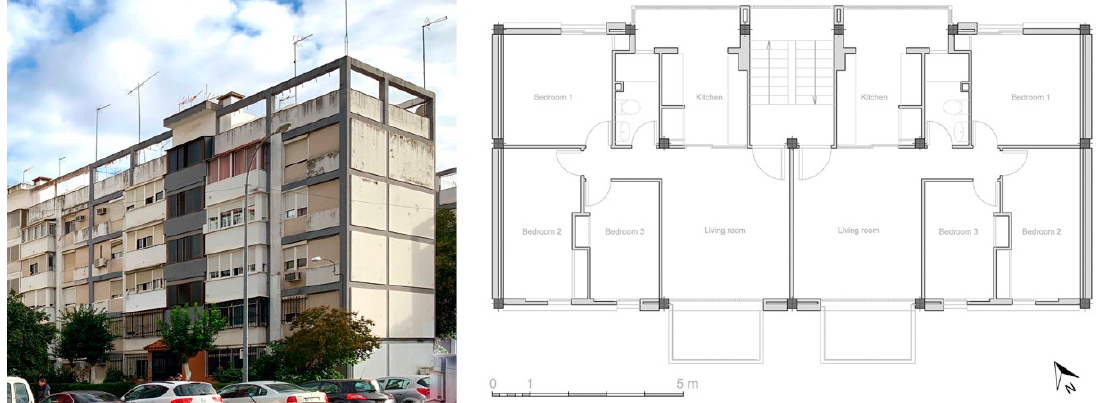
Figure 2. Exterior view and floor plan of a reference building belonging to the case study category. Table 2. Characterization of the parameters of building category case study.